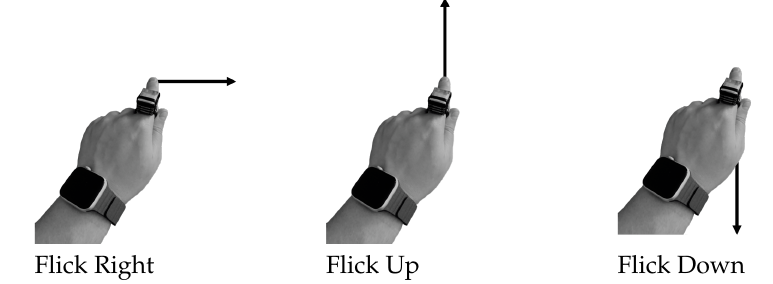
Figure 5. Gestures based on direction information in the